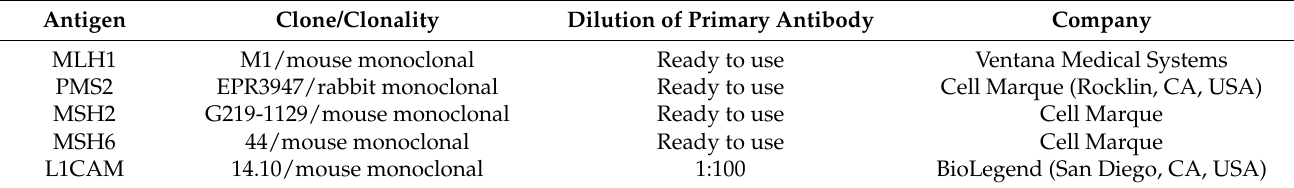
Table 1. Antibodies used for immunohistochemical staining of MMR-proteins and